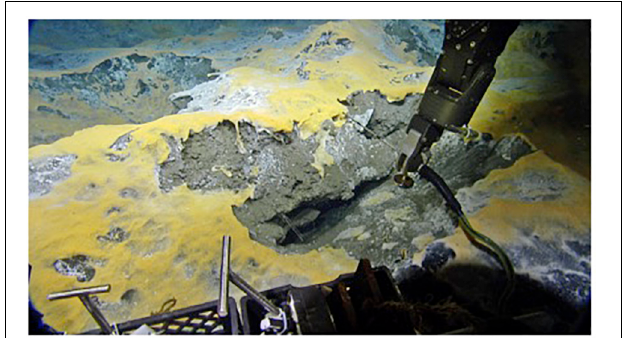
FIGURE 7 | Temporal variability in seafloor fluid flow at the Triton seep site. Temperature probe deployment at the same deep pit site as imaged in Figure 3C , but bubbling had ceased by 05:26 GMT. Copyright Ocean Exploration Trust,